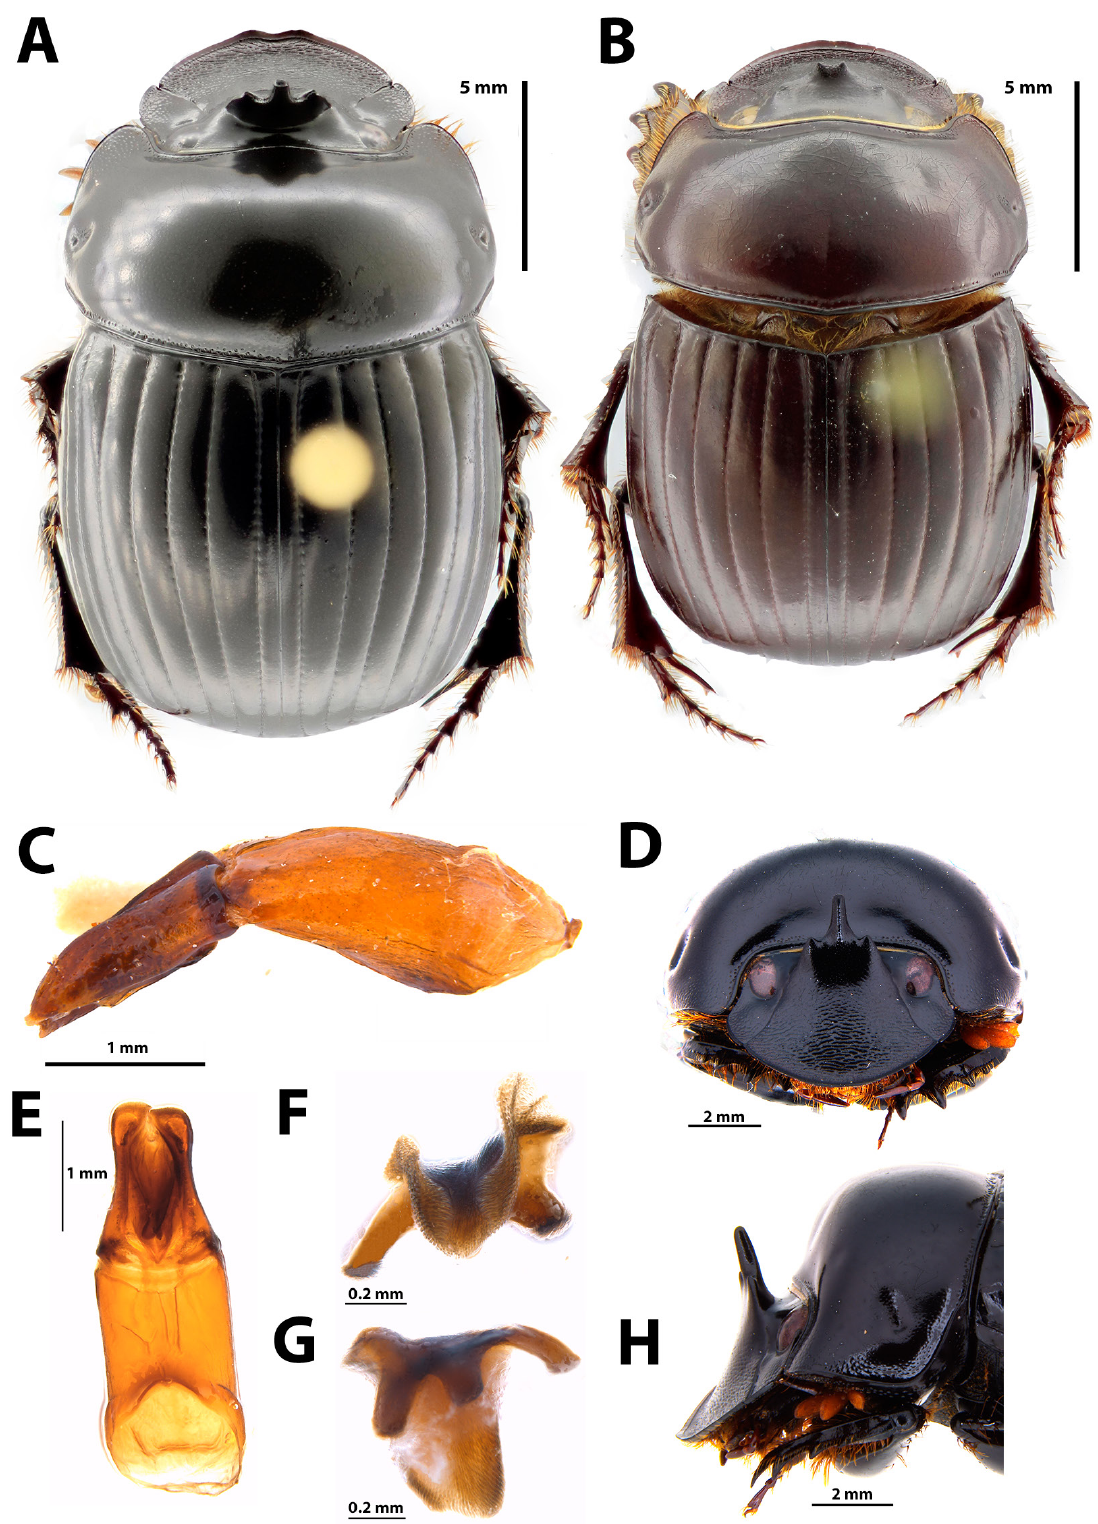
Fig. 5. Dichotomius belus (Harold, 1880). A–B . Dorsal habitus. A . ♂. B . ♀. C . Lateral view of the aedeagus. D . Anterior view of the shape of the cephalic carina. E . Ventral view of the aedeagus. F–G . Lamella copulatrix. H. Lateral view, showing the pronotum and the cephalic carina flattened antero-posteriorly and curved